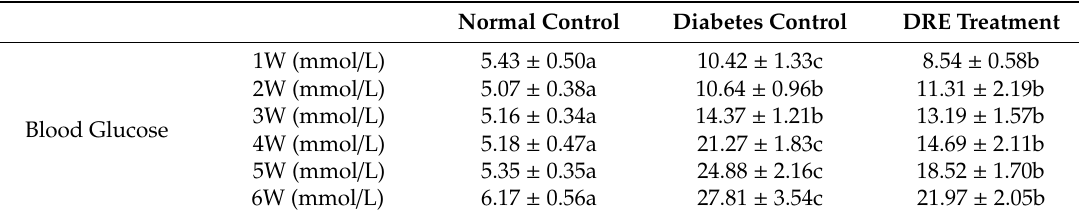
Table 3. Blood glucose levels in the experimental rats. Normal Control Diabetes Control DRE